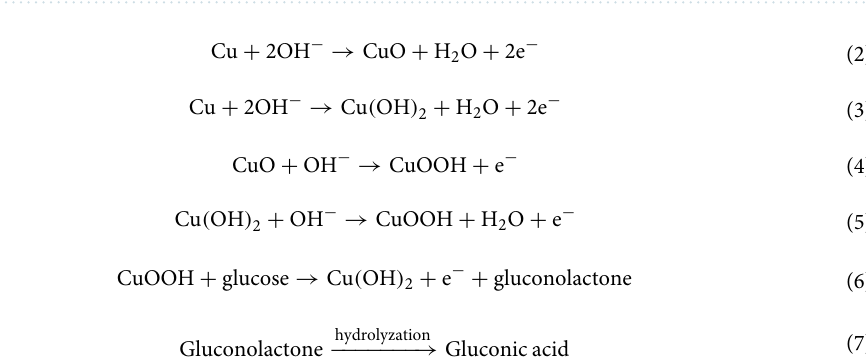
Figure 4. Non-enzymatic detection of glucose. ( a ) CVs of different modified electrodes; bare SPCE, and GO-, and GO/Cu(II)-modified SPCE and ( b ) CVs of bare SPCE, and rGO-, and rGO/Cu(II)-modified SPCE in 0.10 M NaOH solution with the absence and presence of glucose at a scan rate of 50 mV s –1 . ( c ) Chronoamperograms from different glucose concentrations (0.10–12.50 mM) using Cu(II)/rGO-modified electrode at an operating potential of + 0.50 V in 0.10 M NaOH solution and ( d ) the corresponding calibration